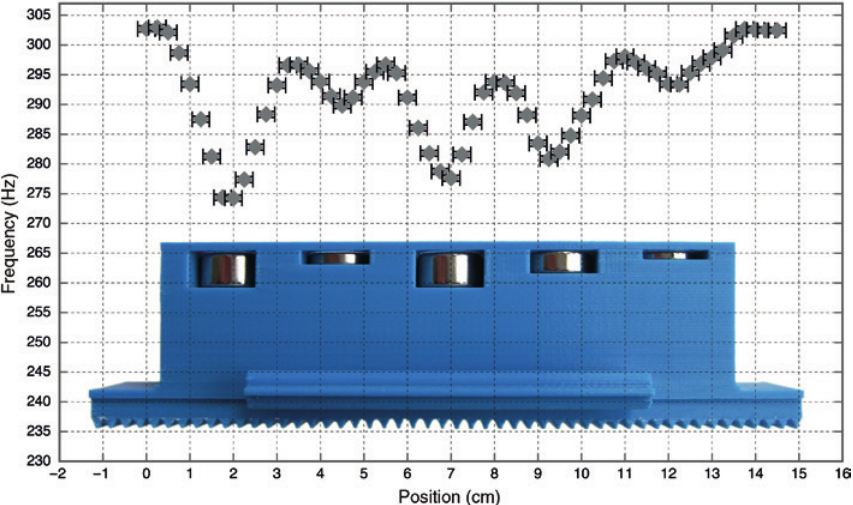
Figure 8: Analysis of a magnetic domain sample with neodymium magnets of varying